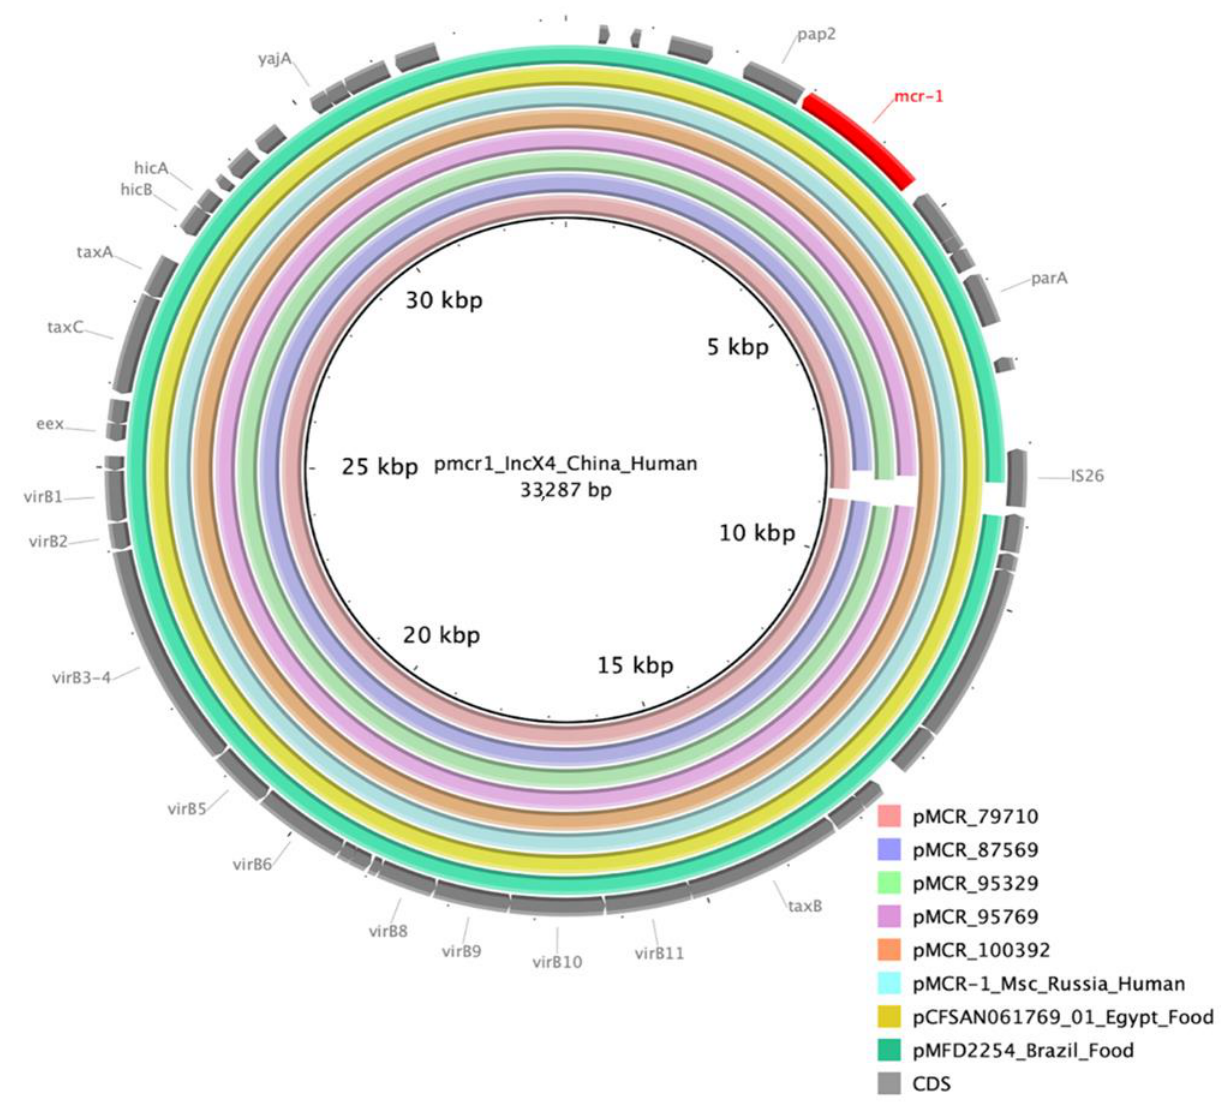
Figure 3. Sequence alignment of five IncX4 mcr -bearing plasmids from this study and references from GenBank. The sequence of IncX4 plasmid pmcr1 (GenBank acc. no. KU761327) was used as a reference (inner circle). The concentric circles show similar plasmids from this study and GenBank references and are colored according to legend. Gaps in the circles correspond to plasmid regions which are missing compared to the reference. The key plasmid genes and mcr-1.1 are shown in the outer circle with gray and red arrows.